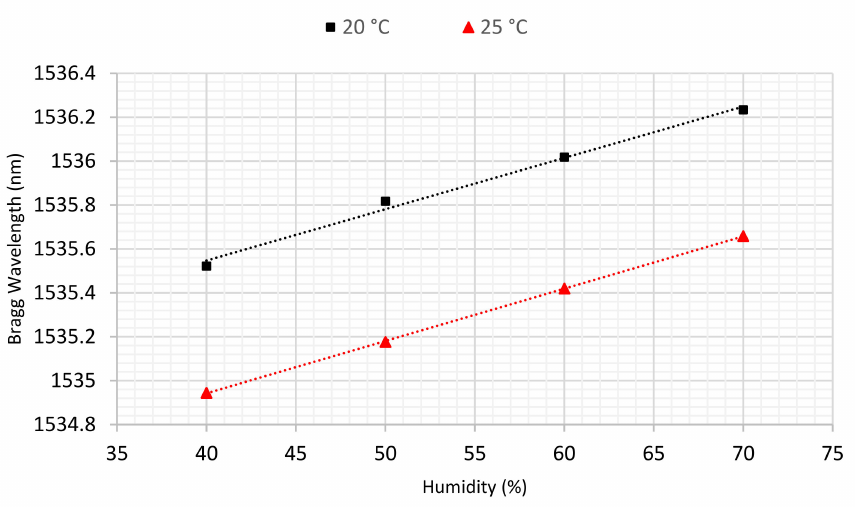
Figure 6. Humidity sensitivity of the polymer sensor at 20 and 25 ◦